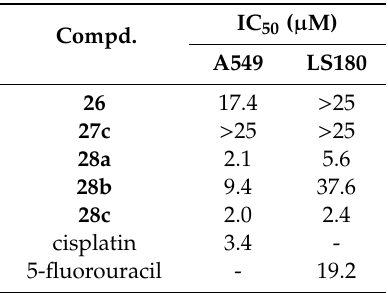
Table 11. Antiproliferative activity of pyrazolo[4,3- e ][1,2,4]triazolo[4,3-b][1,2,4]triazine derivatives in lung cancer A549 and colon cancer LS180 cells.